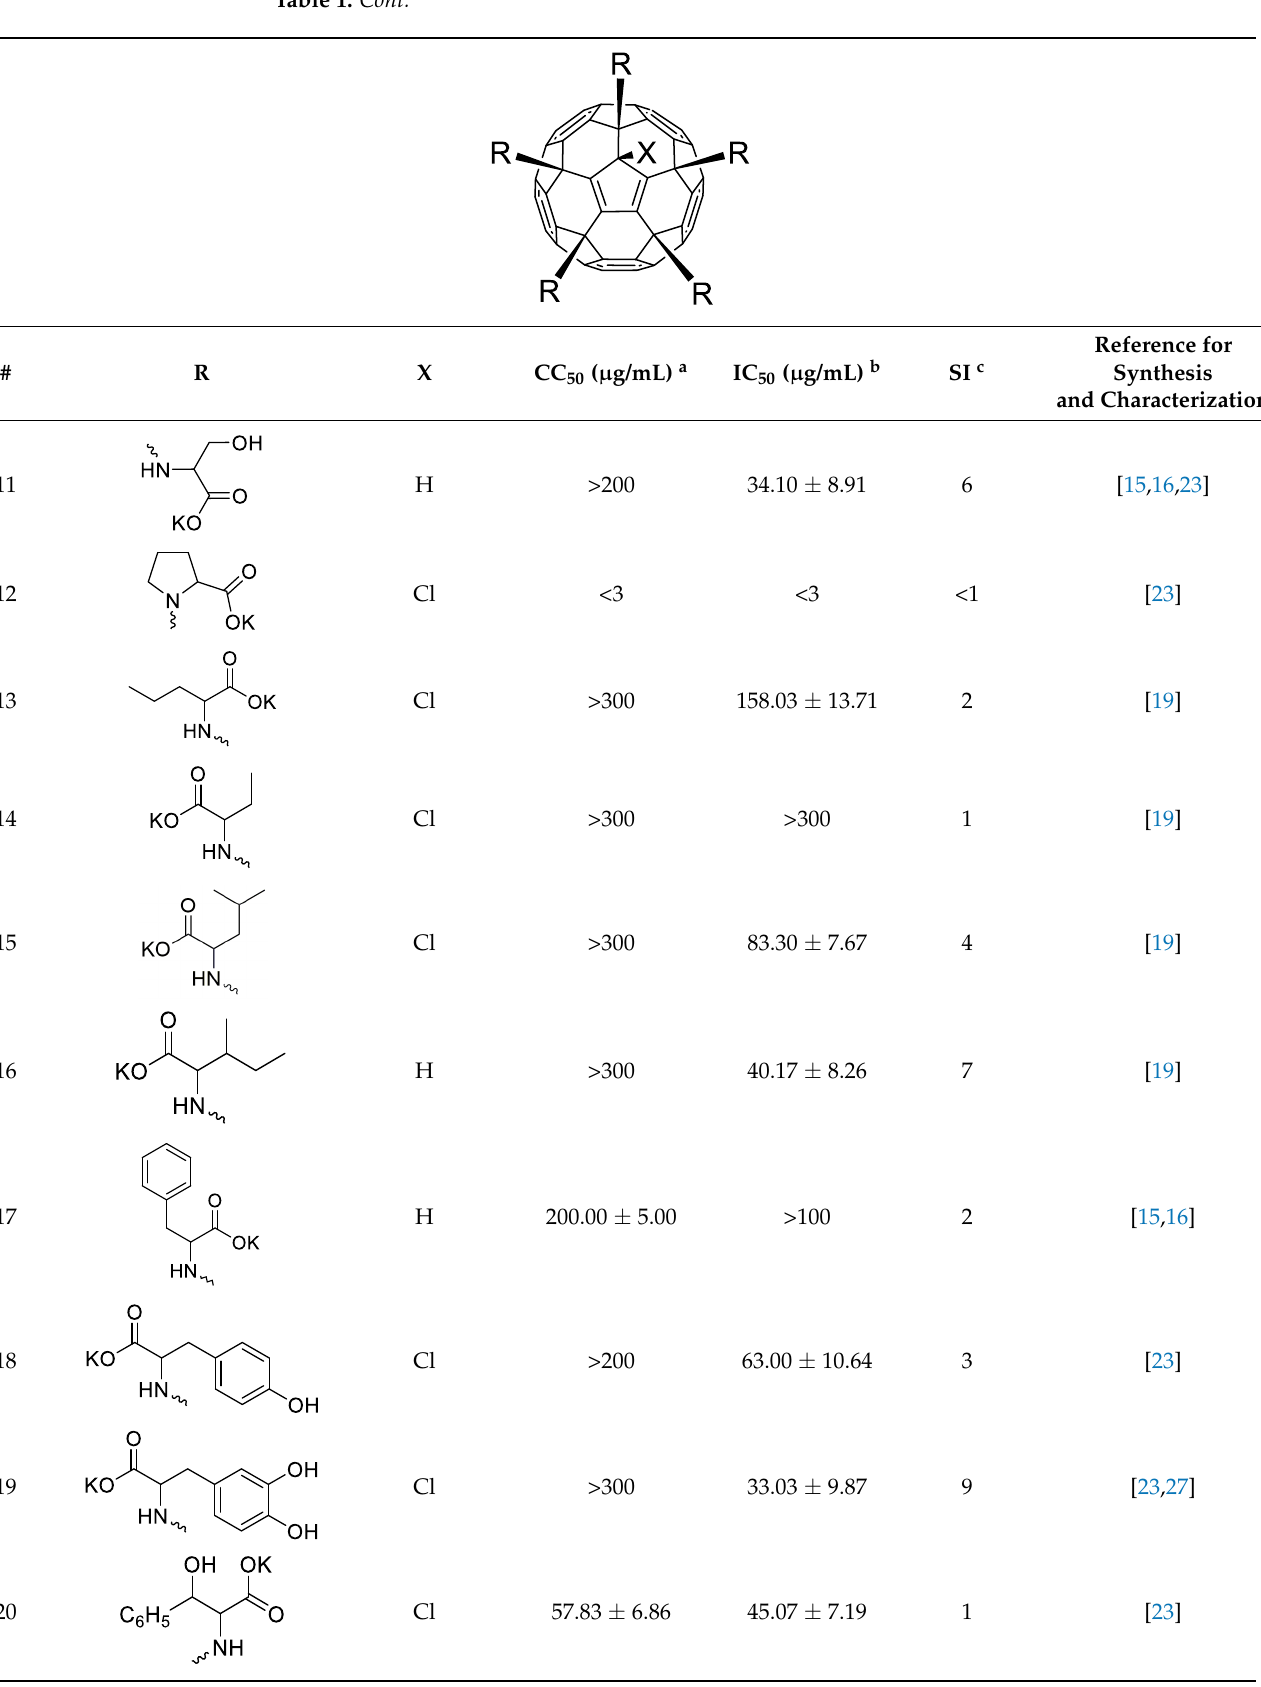
Table 1. Antiviral activity of the water- soluble fullerene derivatives against Influenza А/Puerto Table 1. Cont. Rico/8/34 (H1N1) virus in MDCK